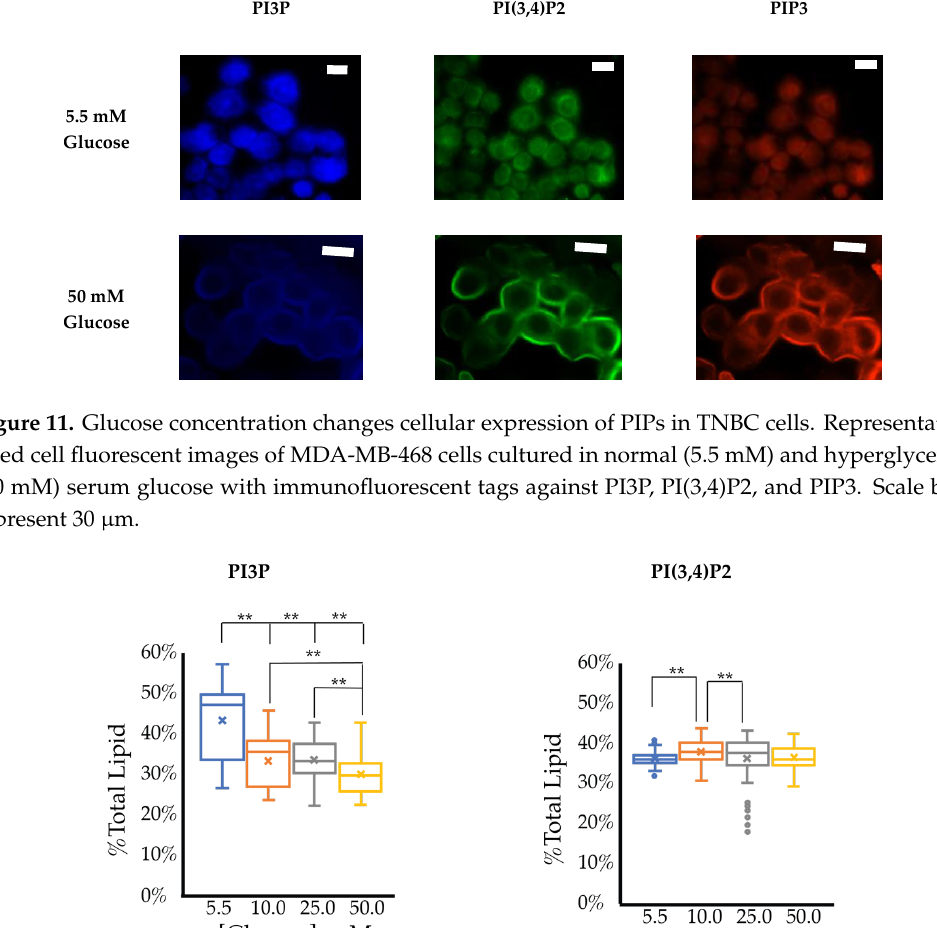
Figure 11. Glucose concentration changes cellular expression of PIPs in TNBC cells. Representative